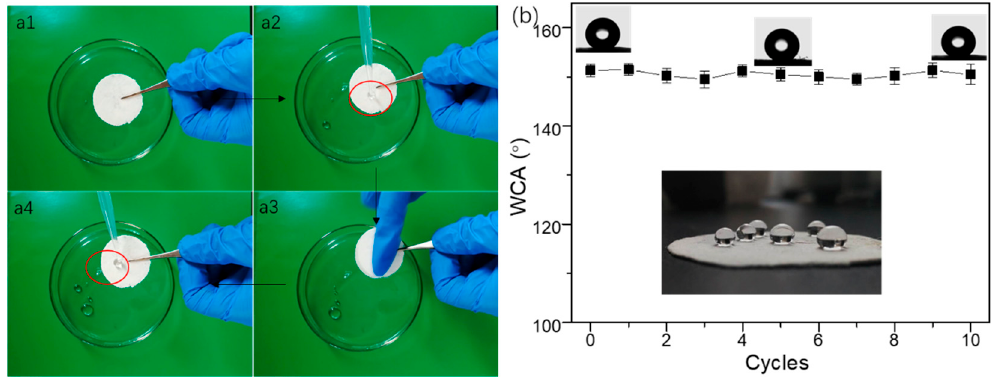
Figure 7. ( a1 – a4 ) Illustration of mechanical stability of the superhydrophobic coating; ( b ) The variation of water contact angles (CAs) of the as-prepared paper versus the number of finger-wipe cycles.